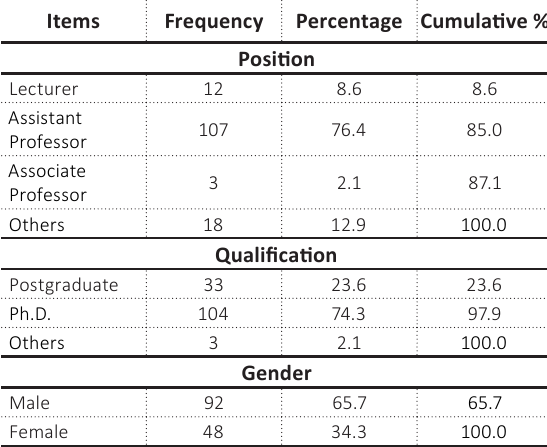
Table 3 demonstrates the five factors exam- ined and their means and standard